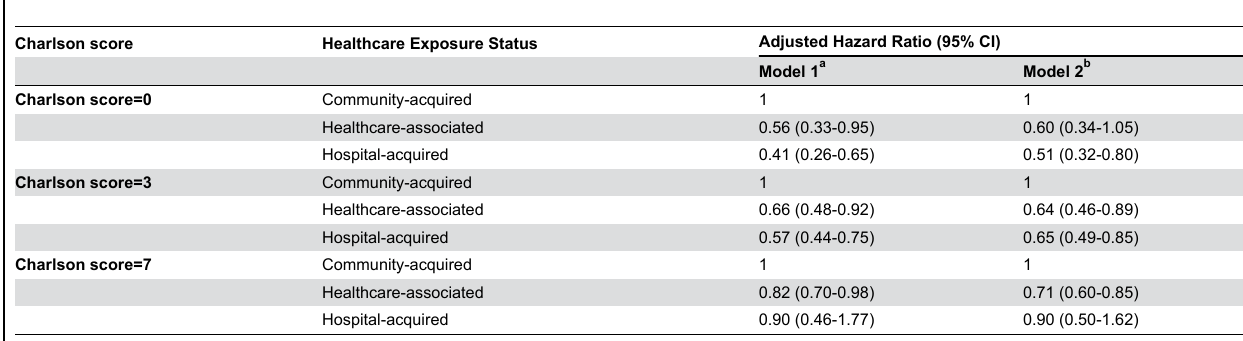
Table 3. Effect of Healthcare Exposure on Time to Appropriate Antibiotic